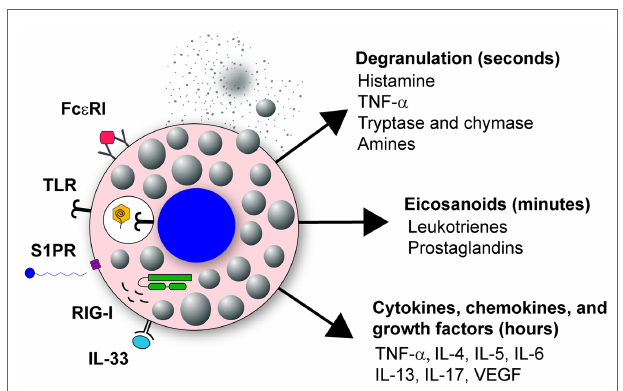
FiguRe 1 | Mast cell activation in response to viral infection . Mast cells are classically known for their response to polyvalent cross-linking of IgE in the Fc ϵ R1 receptor, which is important in protective immunity to helminth worm infection and pathologically associated with allergic disease. However, mast cells also are important tissue sentinel cells for initiating inflammatory response to pathogens. Mast cells can recognize and respond to viruses through several different receptors. These receptors include TLR signaling, such as TLR3 detection of dsRNA, sphingosin-1-phosphate (S1P) binding to its receptor S1PR, and RIG-I recognition of uncapped vRNA. Engagement of these receptors results in mast cell activation leading to immediate degranulation, the de novo synthesis of eicosanoids within minutes of activation, and the de novo synthesis of numerous cytokines, chemokines, and growth factors within hours of